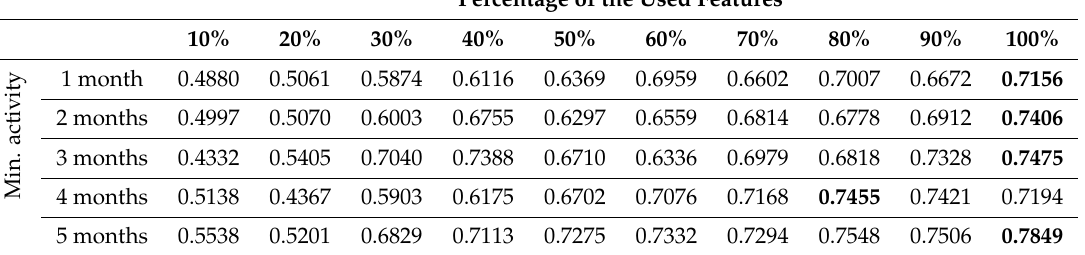
Table A11. F-score macro average for the Decision Tree classification of two levels of the hierarchy in the Enron dataset. The values which are bolded are the best results for a given minimum communication